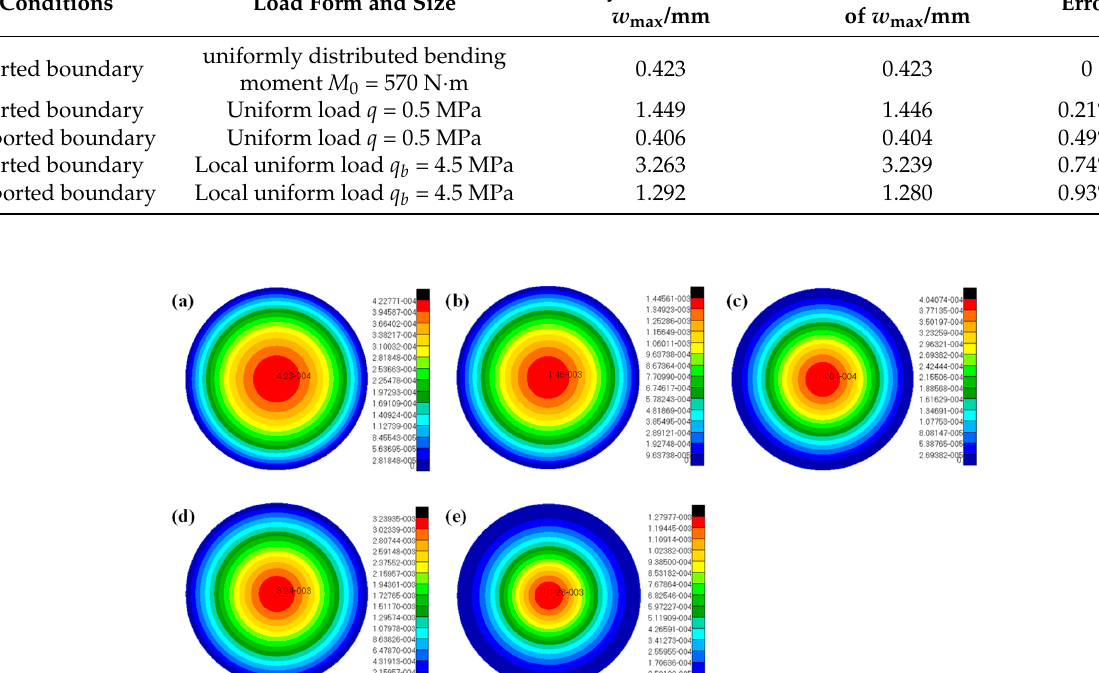
Table 3. Maximum deflection of bending for circular SP-HCs under different loads and boundary constraints. Boundary Conditions